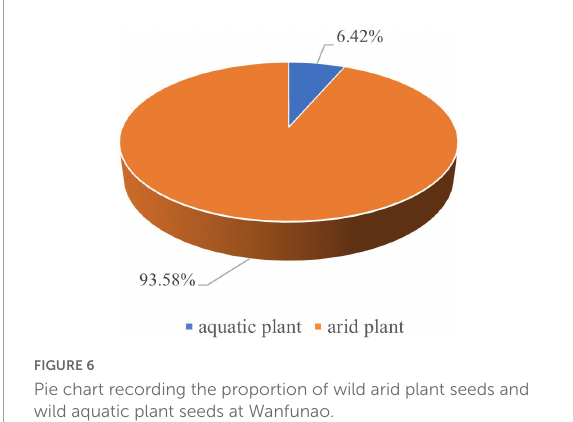
FIGURE6 Pie chart recording the proportion of wild arid plant seeds and wild aquatic plant seeds at Wanfunao.